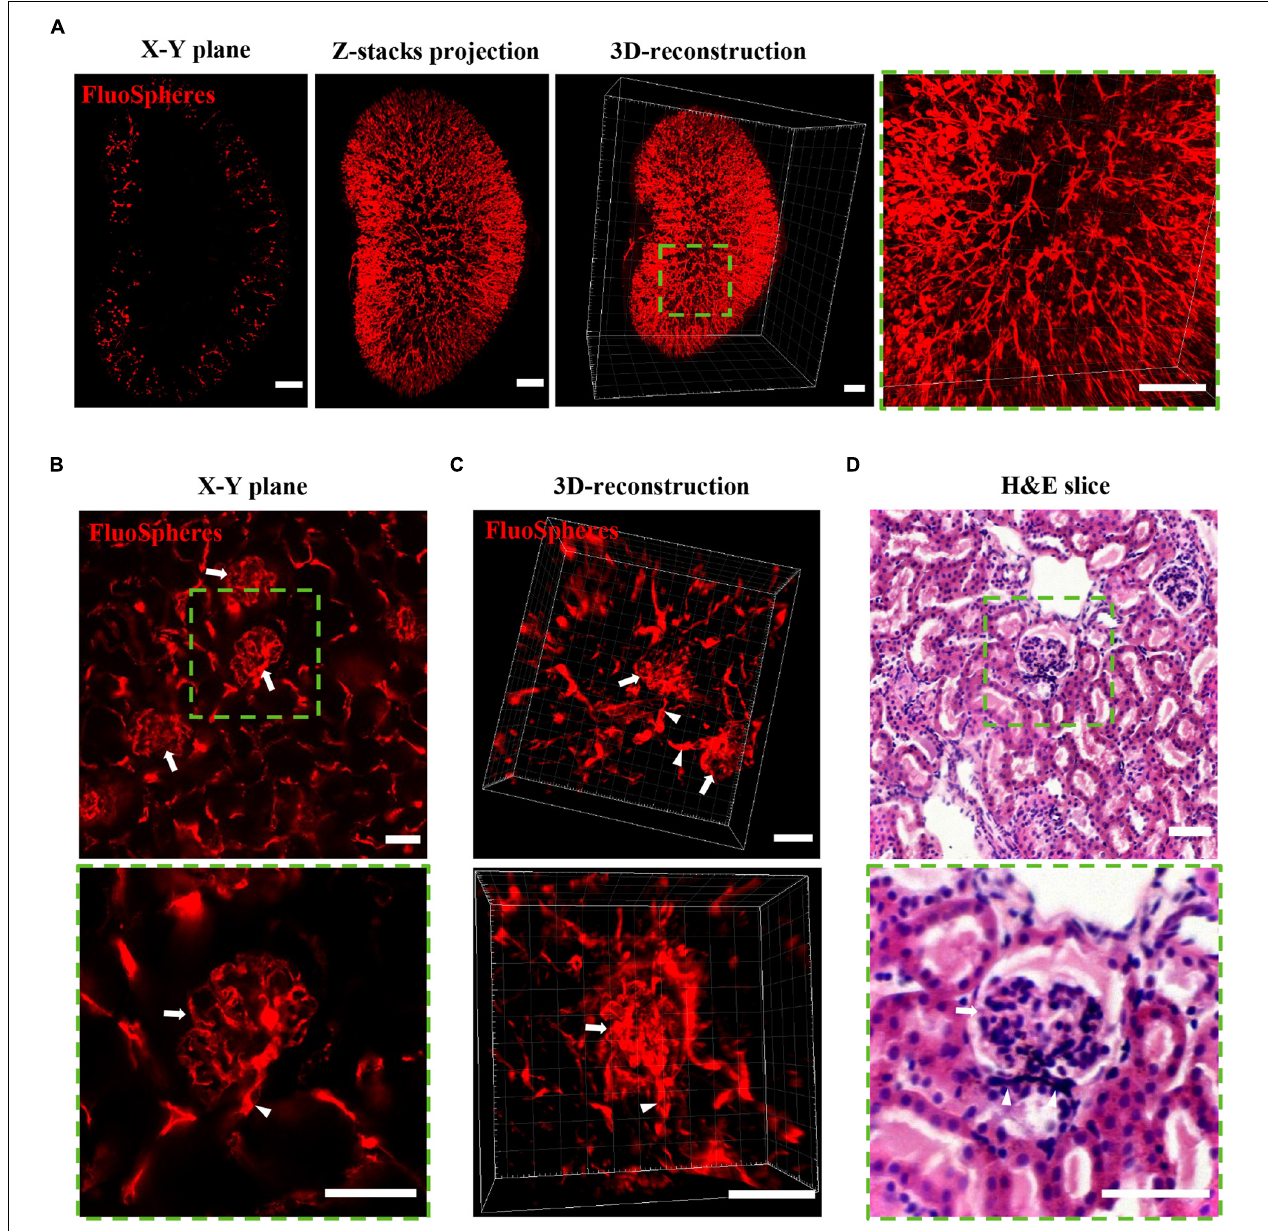
FIGURE 3 | OSP-CUBIC clearly visualizes the structure of the microvasculature and glomerulus. The kidney underwent FluoSphere perfusion or H&E staining. (A) X – Y single-slice plane image, z-stack projection, and 3D-reconstructed of images acquired by LSFM. The 3D reconstruction included 1258 z-section images. Magnification of the square area of the 3D reconstruction showed the dendritic-like renal microvasculature and glomerulus in the distal end. Scale bar = 1 mm. Representative images show the structure of the glomerulus (arrow) and connected afferent/efferent arteriole (triangle) on the X – Y plane (B) and 3D reconstruction (C) by confocal microscopy and H&E staining (D) . Scale bar = 50 µ m. Green square areas are magnified. H&E, hematoxylin-eosin. The microvasculature was labeled with FluoSphere